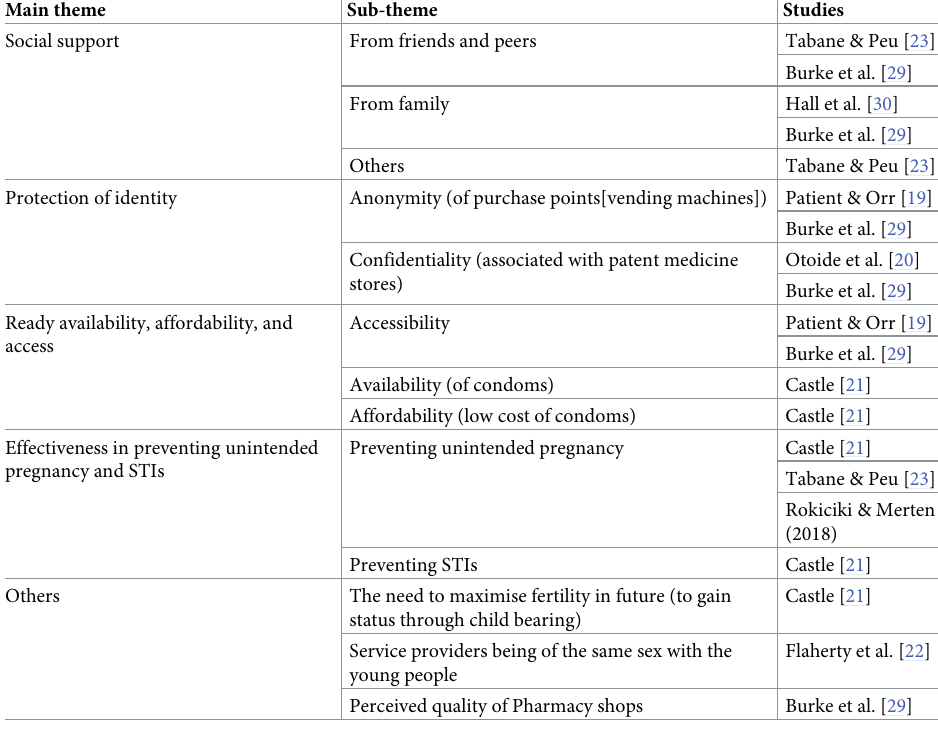
Table 2. Motivations for contraceptive use among young people in